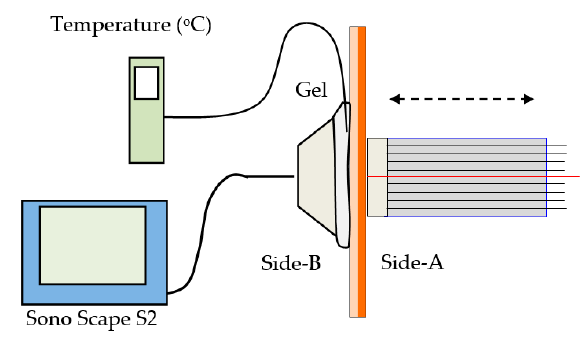
Figure 9. Verification setup with ultrasound.